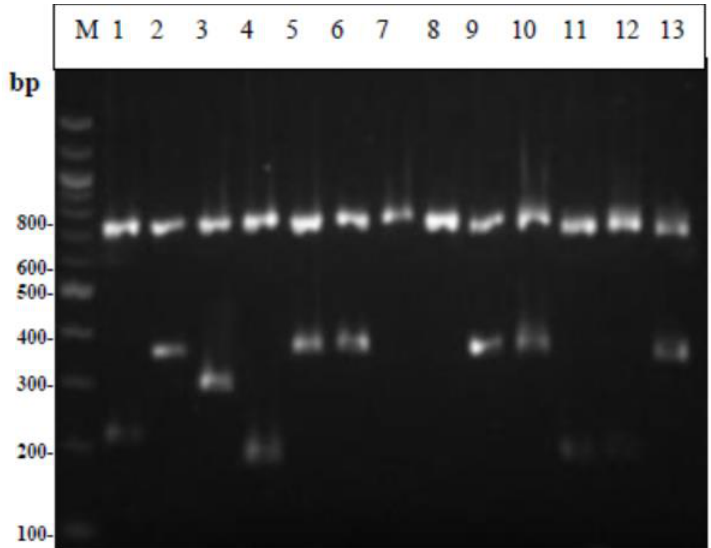
Figure 3. Results from the Multiplex PCR identifying the four genera Lactococcus, Lactobacillus, Streptococcus and Leuconostoc Μ: 10 0 bp DNA ladder, 1: Leuconostoc pseudomesenteroides DSM 20193, 2: Lactococcus garvieae subsp . garvieae DSM 20684, 3: Streptococcus thermophilus LMG 13565, 4: MRS-8, 5: MRS-9, 6: M17-6 .